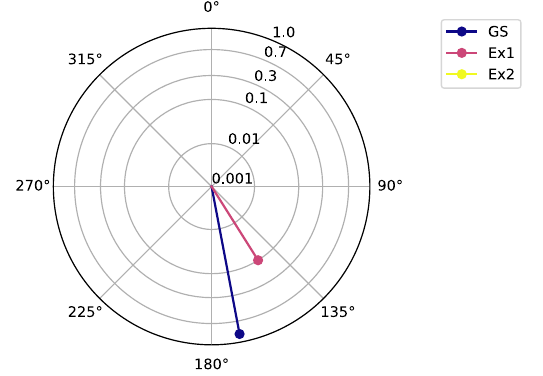
FIG. 4. An exemplary eigenstate clock featuring the complex summands of α for τ =1. Here, the term corresponding to the ground state | ψ 0 | 2 exp ( − iE 0 τ) and the first excited-state term | 2 exp ( − iE τ) lie quite closely together in phase, which leads | ψ 1 1 to problematic constructive interference. However, as the point- ers rotate with their respective eigenenergies, they will be well separated for suitable larger τ . Note that in this instance, the sum- mands corresponding to higher excited eigenstates are taken to be very small and are not